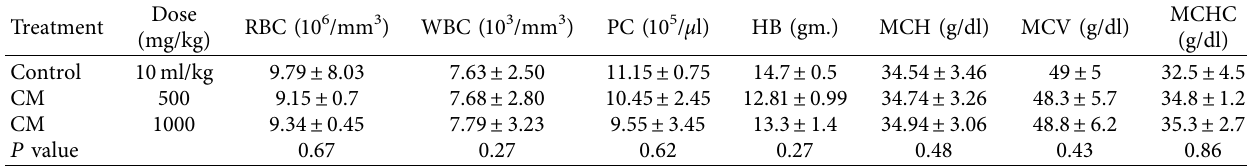
Table 3: Efect of C. martini essential oil on hematological parameters in mice.